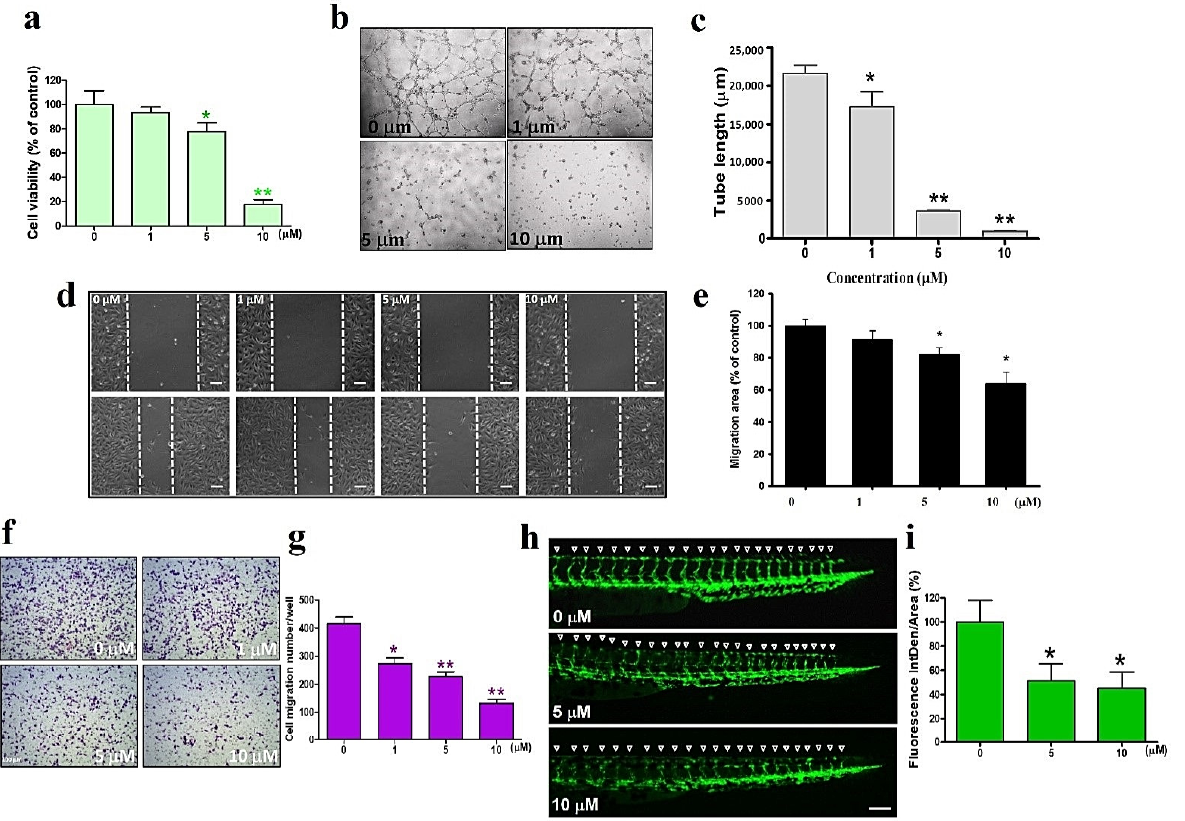
Figure 5. Antiangiogenic effects of sinularin in EA.hy926 cells and zebrafish. ( a ) Cell viability of EA.hy926 cells under sinularin treatment. ( b ) Tube length morphology on Matrigel after treatment with VEGF or control, with or without sinularin (0–10 µ M) in EA.hy926 cells. ( c ) Quantitative results of tube length after treatment with VEGF or control, with or without sinularin (10 µ M) in EA.hy926 cells. ( d ) The mobility in EA.hy926 cells was assessed using a wound healing assay. ( e ) Quantitative results of cell migration area. ( f ) Transwell analysis of EA.hy926 cells migration